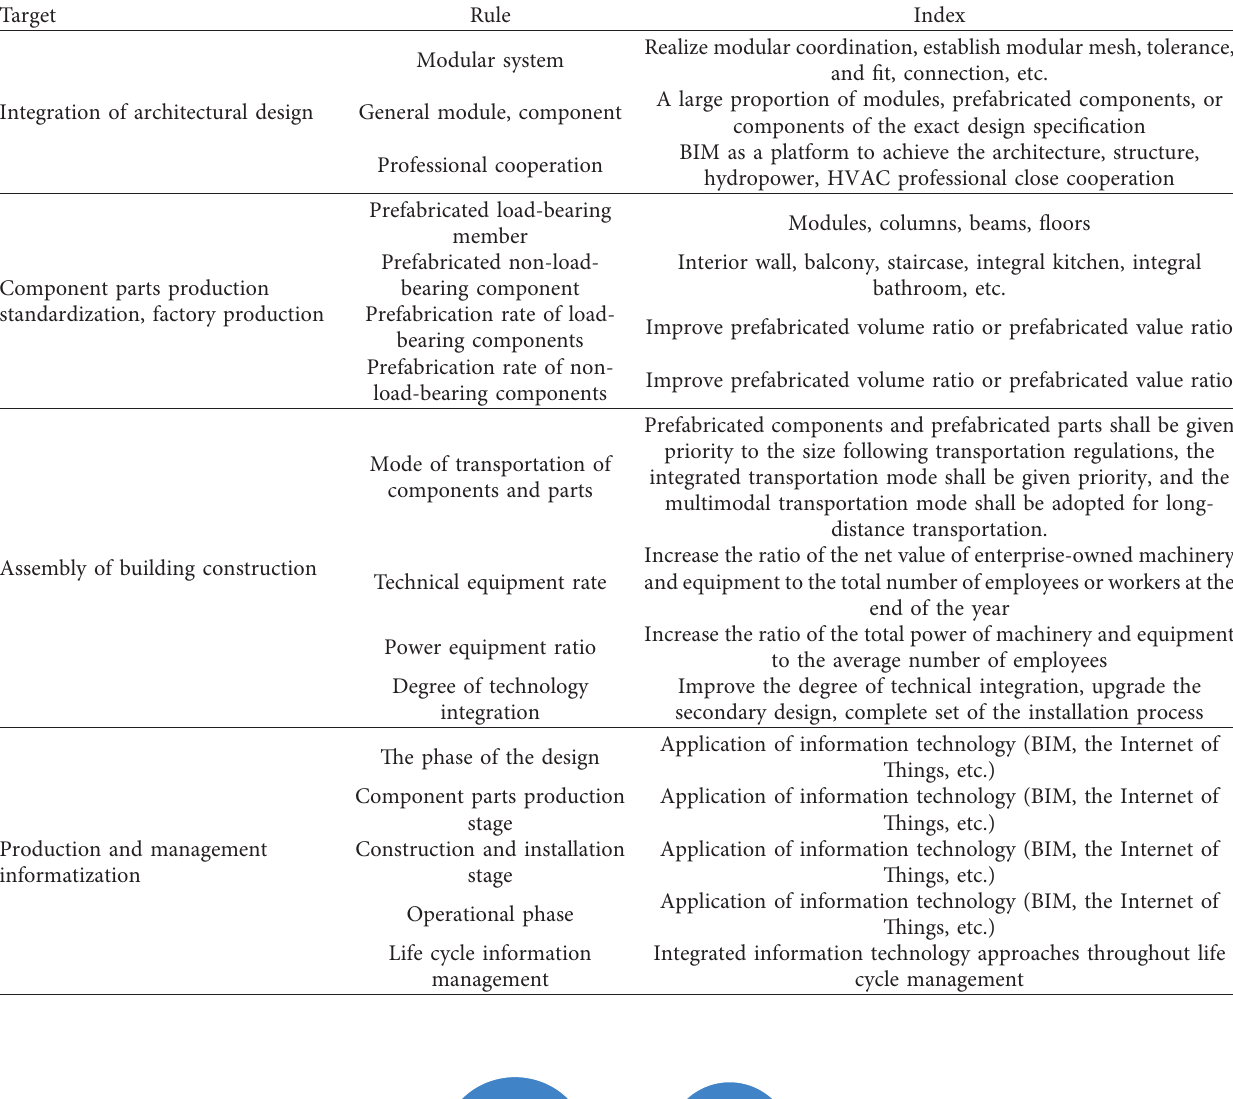
Table 2: Container modular building system integration target list.